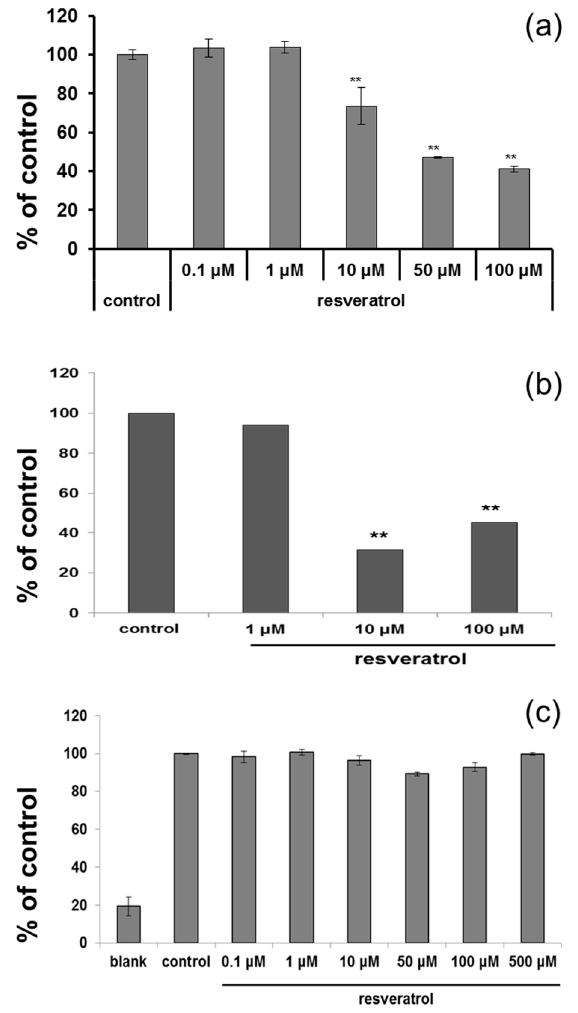
Figure 2. ( a ) ELISA was carried after adding L-DOPA to normal human melanocytes which were treated with resveratrol for three days to measure tyrosinase activity; ( b ) Cells were treated with resveratrol for 72 h and amount of melanin was measured; ( c ) Direct inhibition of tyrosinase by resveratrol was studied using a cell-free system.